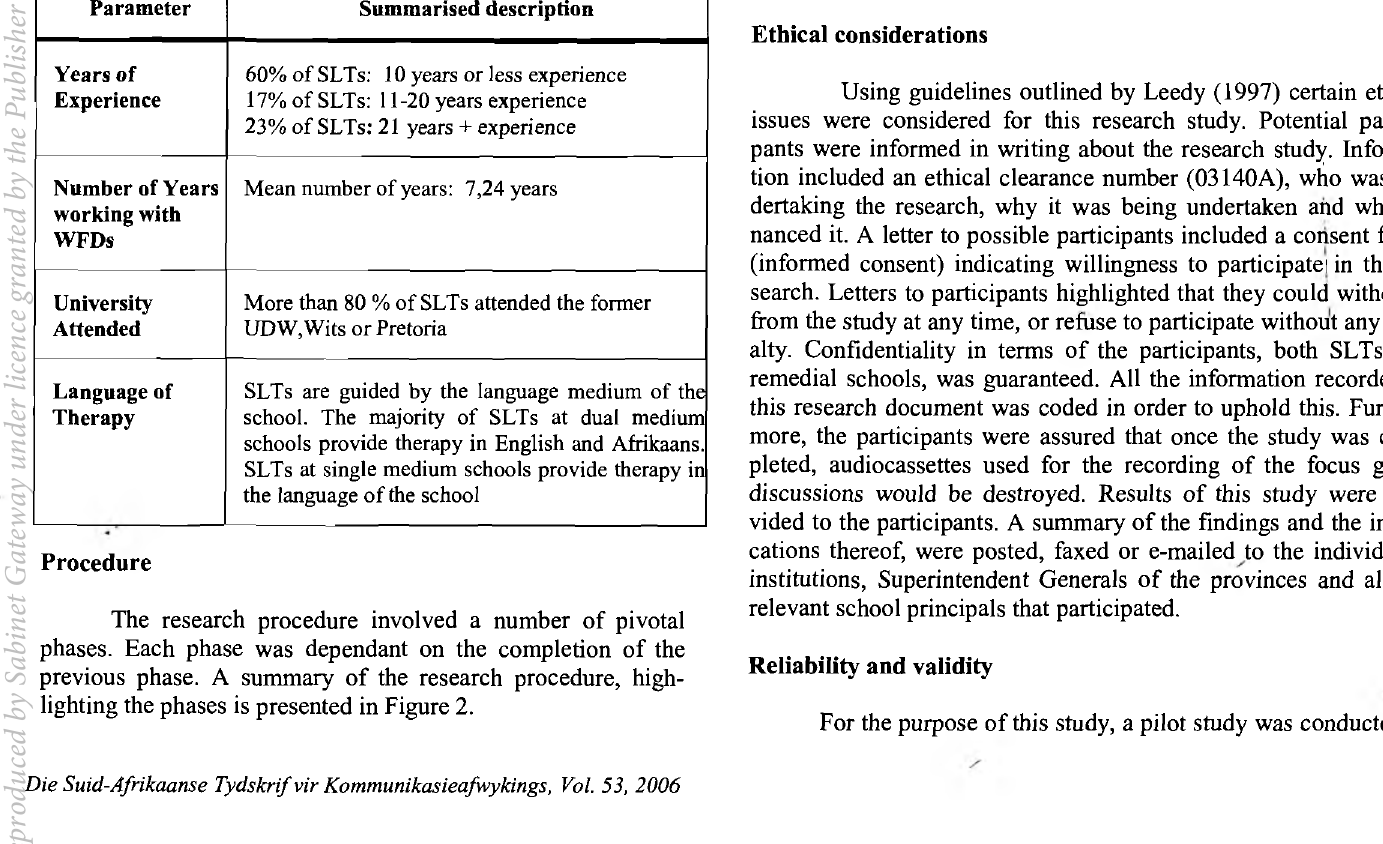
Figure 2: Summary of Research